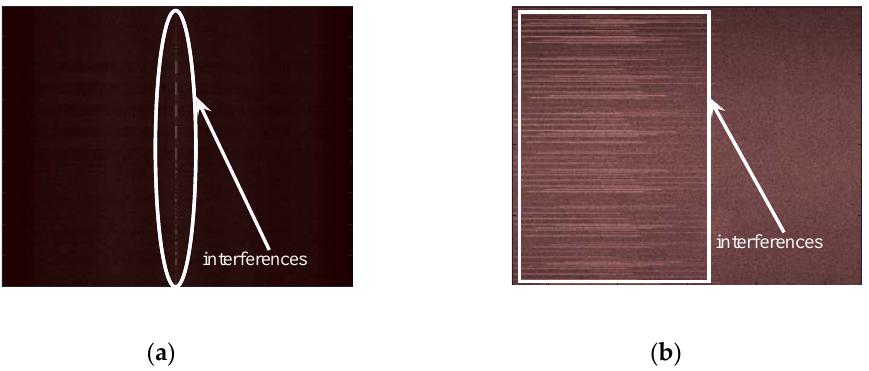
Figure 1. Synthetic Aperture Radar (SAR) echoes corrupted with ( a ) and ( b ) narrow-band interference (NBI) in range-frequency azimuth-time domain and wide-band interference (WBI) in azimuth-frequency range-time domain.